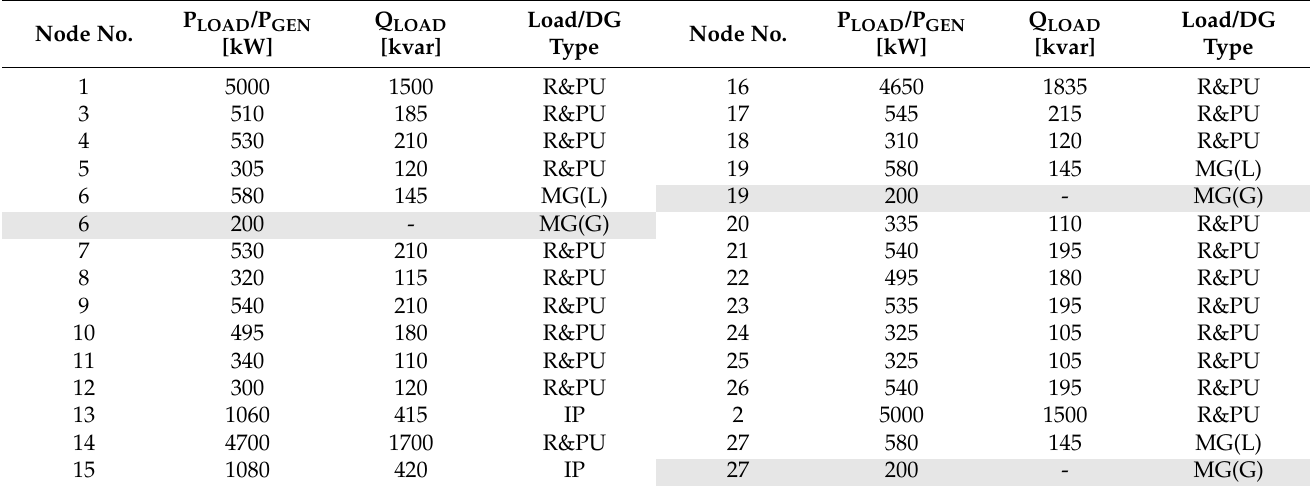
Table A5. Distributed generation sources and energy consumers connected to the MV distribution network with LV microgrids.